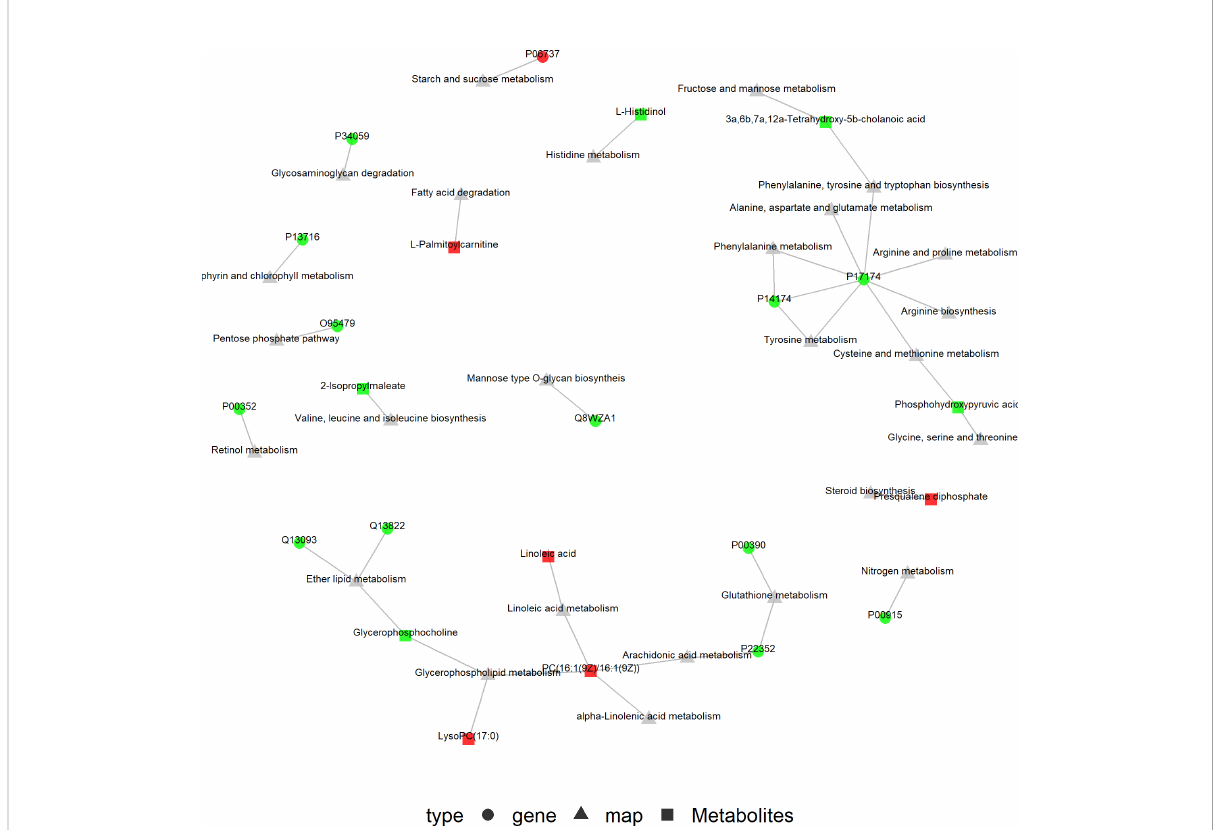
FIGURE 9 KGML network of the differential genes and metabolites. The squares represent genes and the triangles represent metabolites. Red represents up-regulated genes or metabolites, and bright green represents down-regulated genes or